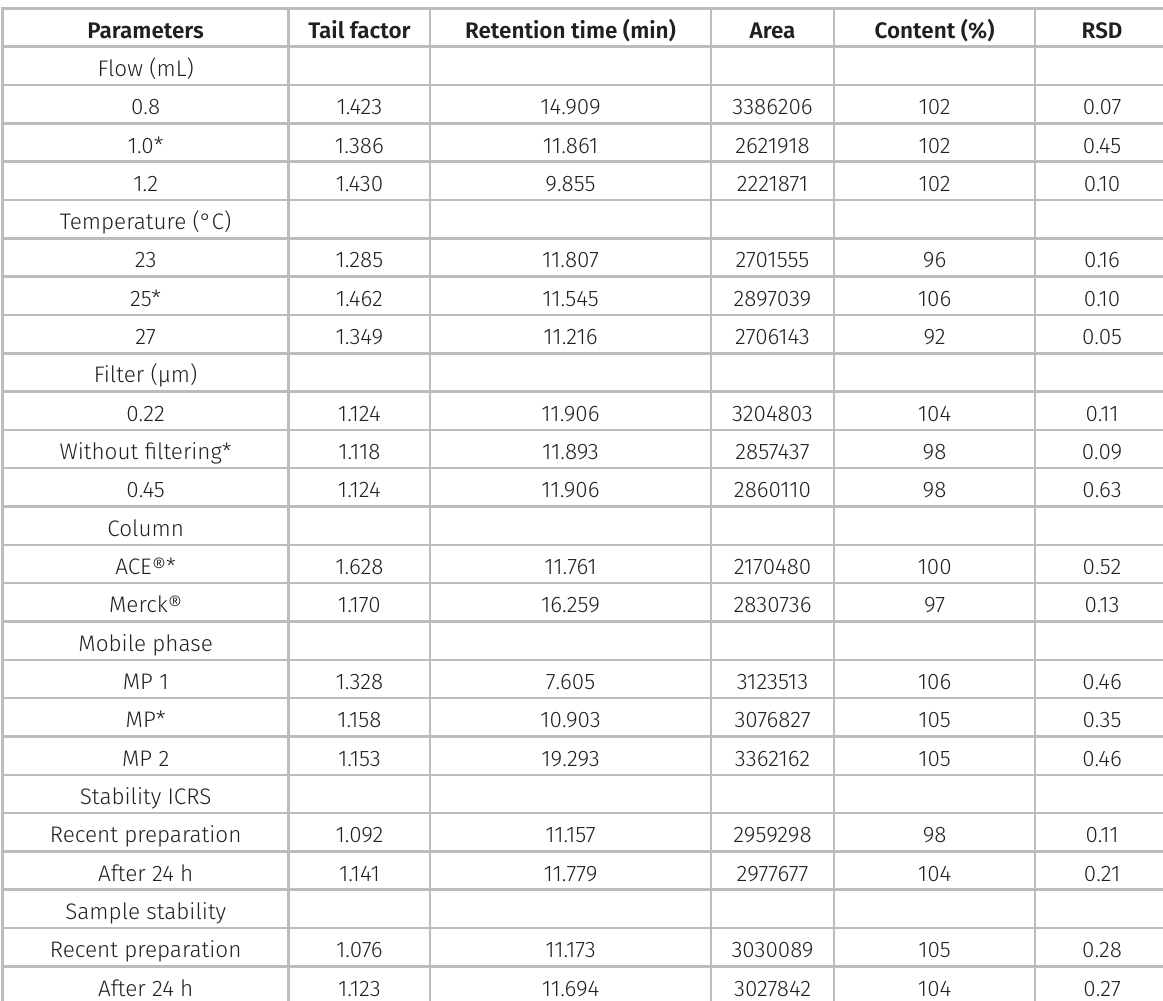
Table V. Robustness results. Parameters Tail